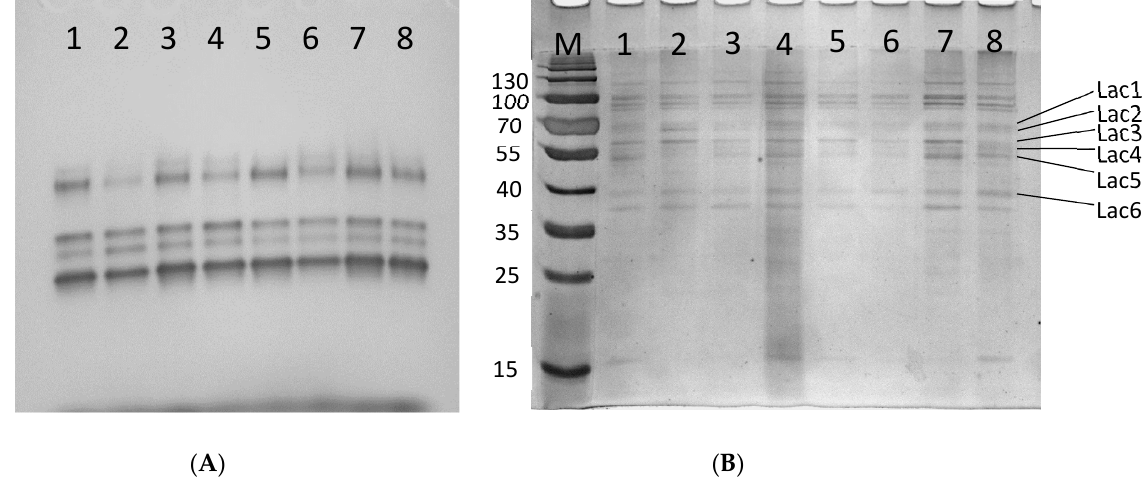
Figure 3. Laccase activity staining ( A ) and SDS-PAGE profile ( B ) of proteins found in the post-culture liquid of C. unicolor ; 1, control (no induction); 2, 4°C; 3, 40°C; 4, ferulic acid; 5, veratric acid; 6, Cd; 7, Cu; 8, Mn; laccase bands are indicated.